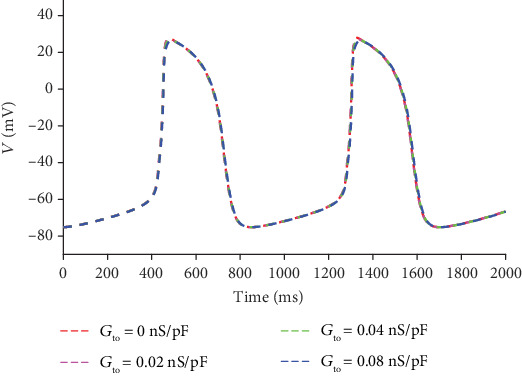
APs corresponding to different Ito.